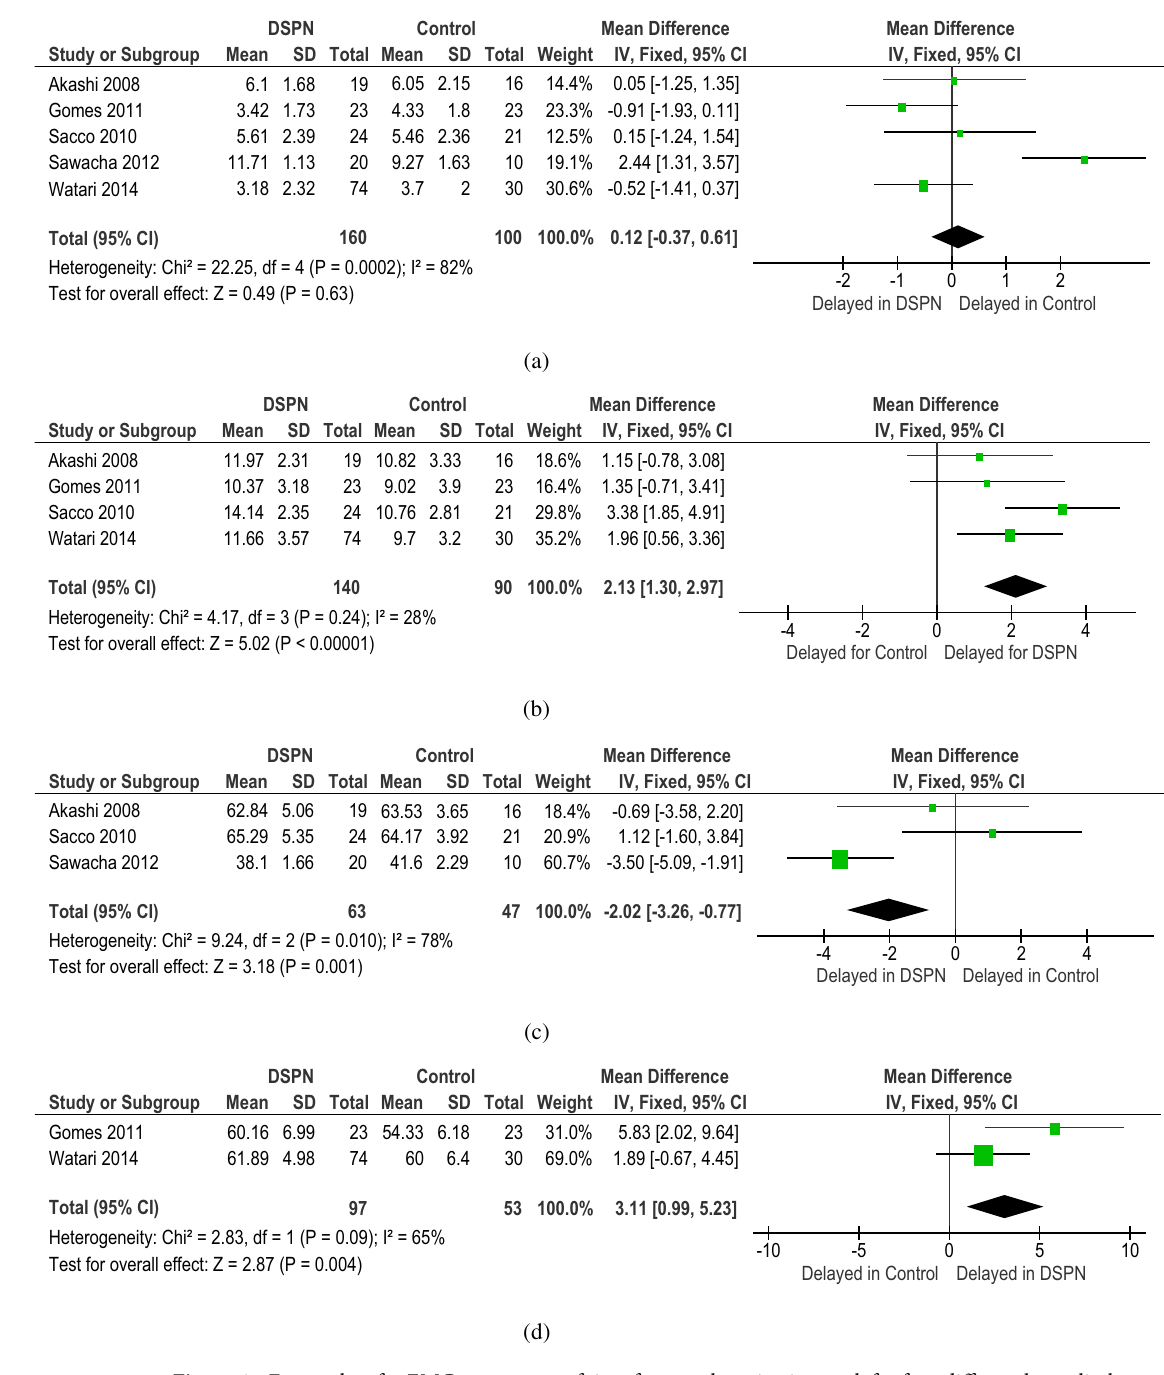
Figure 4. Forest plots for EMG parameters of time for muscle activation peak for four different lower limb muscles ( a ) TA, ( b ) VL, ( c ) LG, ( d ) GM for DSPN and control